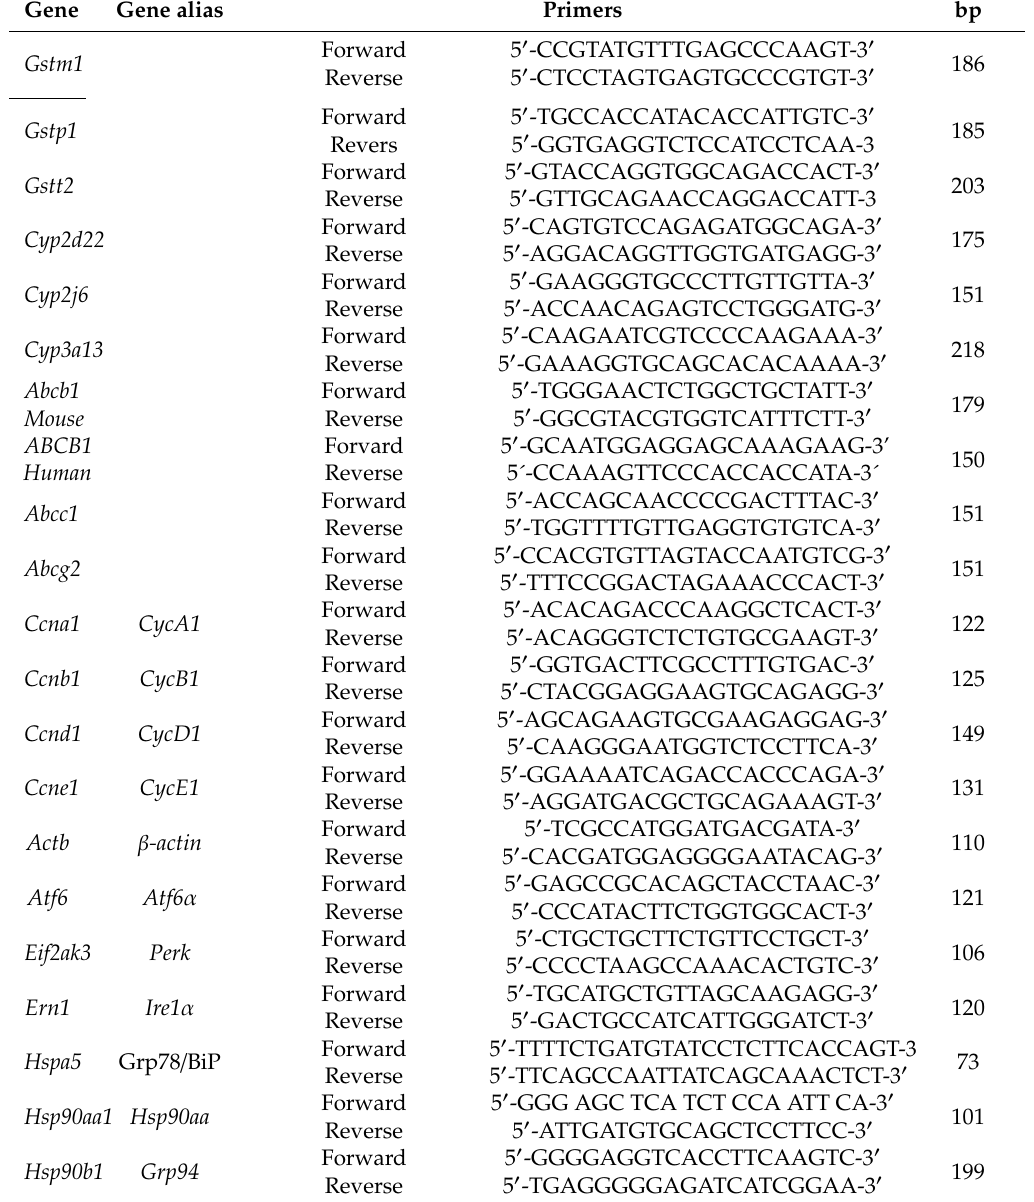
Table 2. Structure of